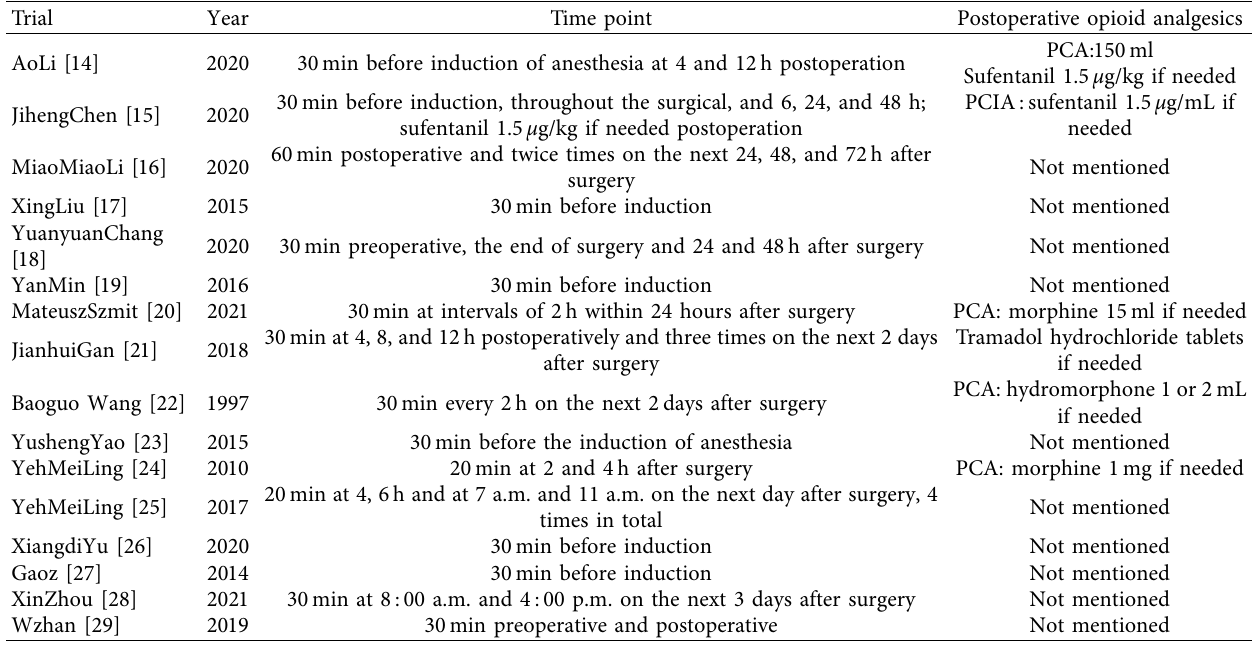
Table 3: Details of